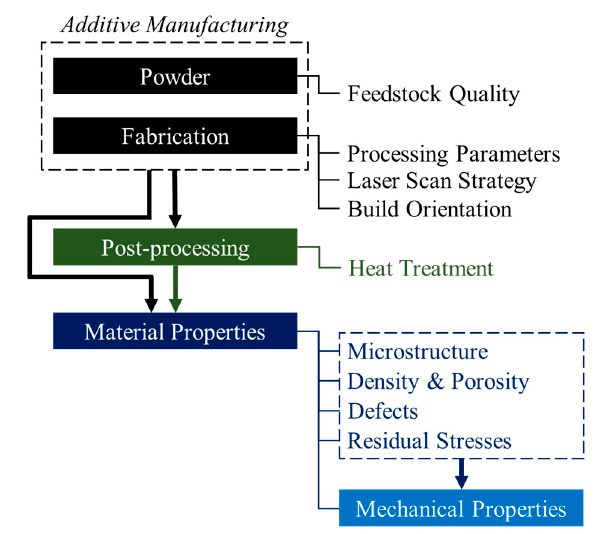
Figure 2. Overview of the aspects covered in the review paper.